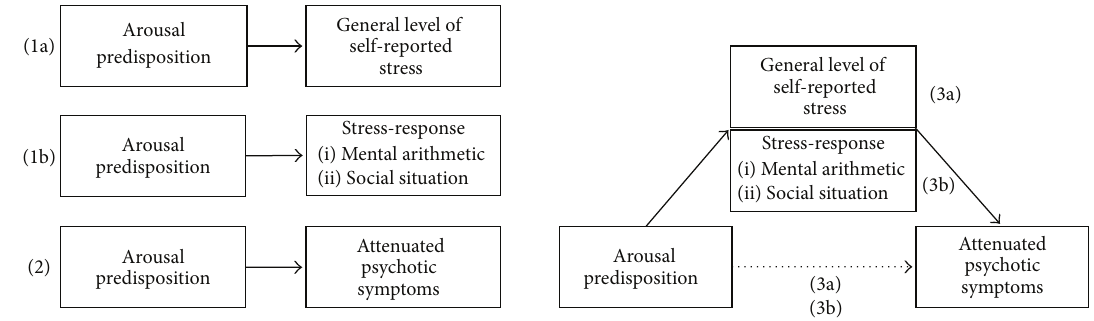
Figure 1: Graphical depiction of the